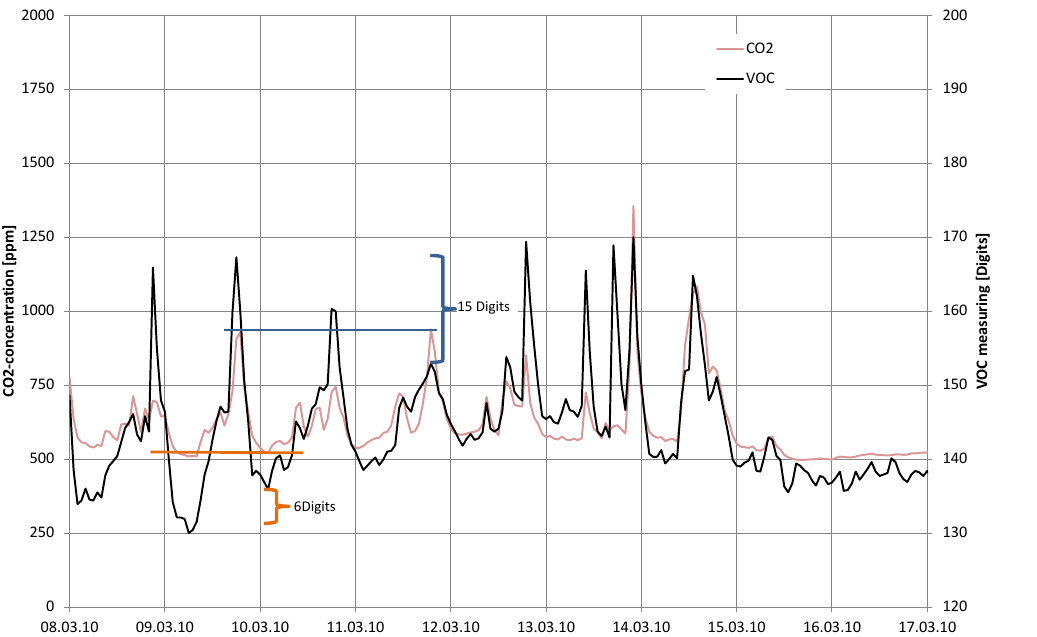
Figure 14. VOC and CO 2 measurements in the living room of one test building over 1 week.